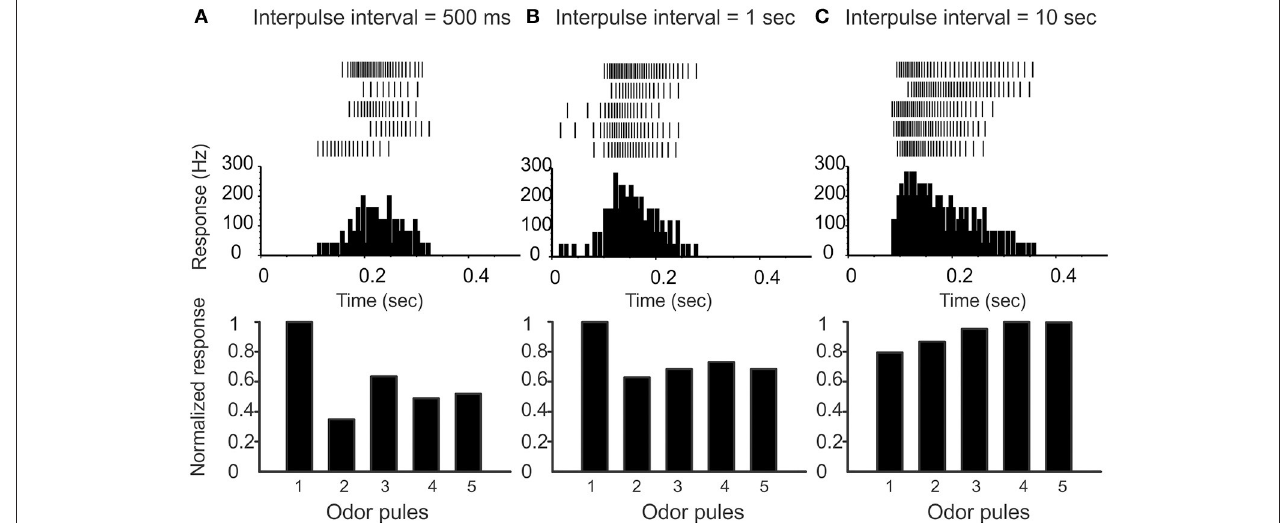
FIGURE 2 | Varying the inter-pulse-interval (IPI) affects the attenuation of PN responses. (A) On top we show raster-plots of a PN response to five pulses in sequence (IPI 500ms). The peristimulus-time-histogram is shown in the middle, and the normalized response per pulse is shown on the bottom. Note that there is a marked attenuation of PN response following the first pulse. (B) IPI = 1s, and the attenuation is less marked. (C) IPI = 10s, which is significantly greater than the AHP-phase; there is no attenuation of PN response.